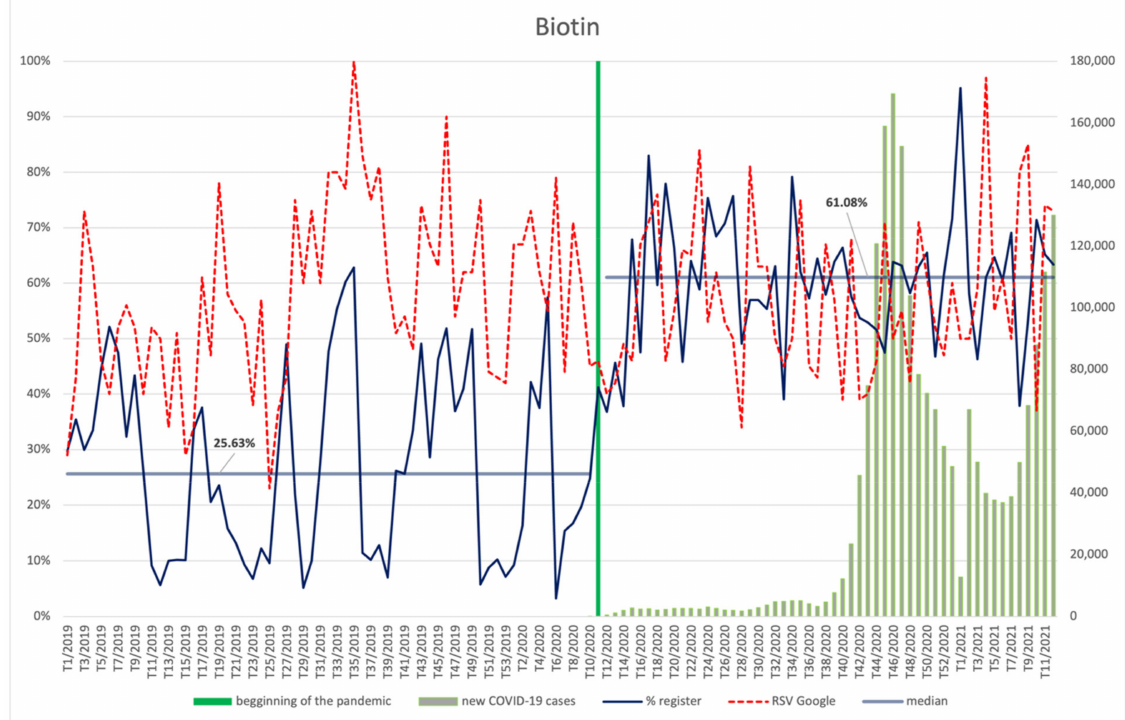
Figure 18. Comparison between the number of new registrations of products containing biotin, the number of COVID-19 cases, and the frequency of search for information on the ingredient in the Google